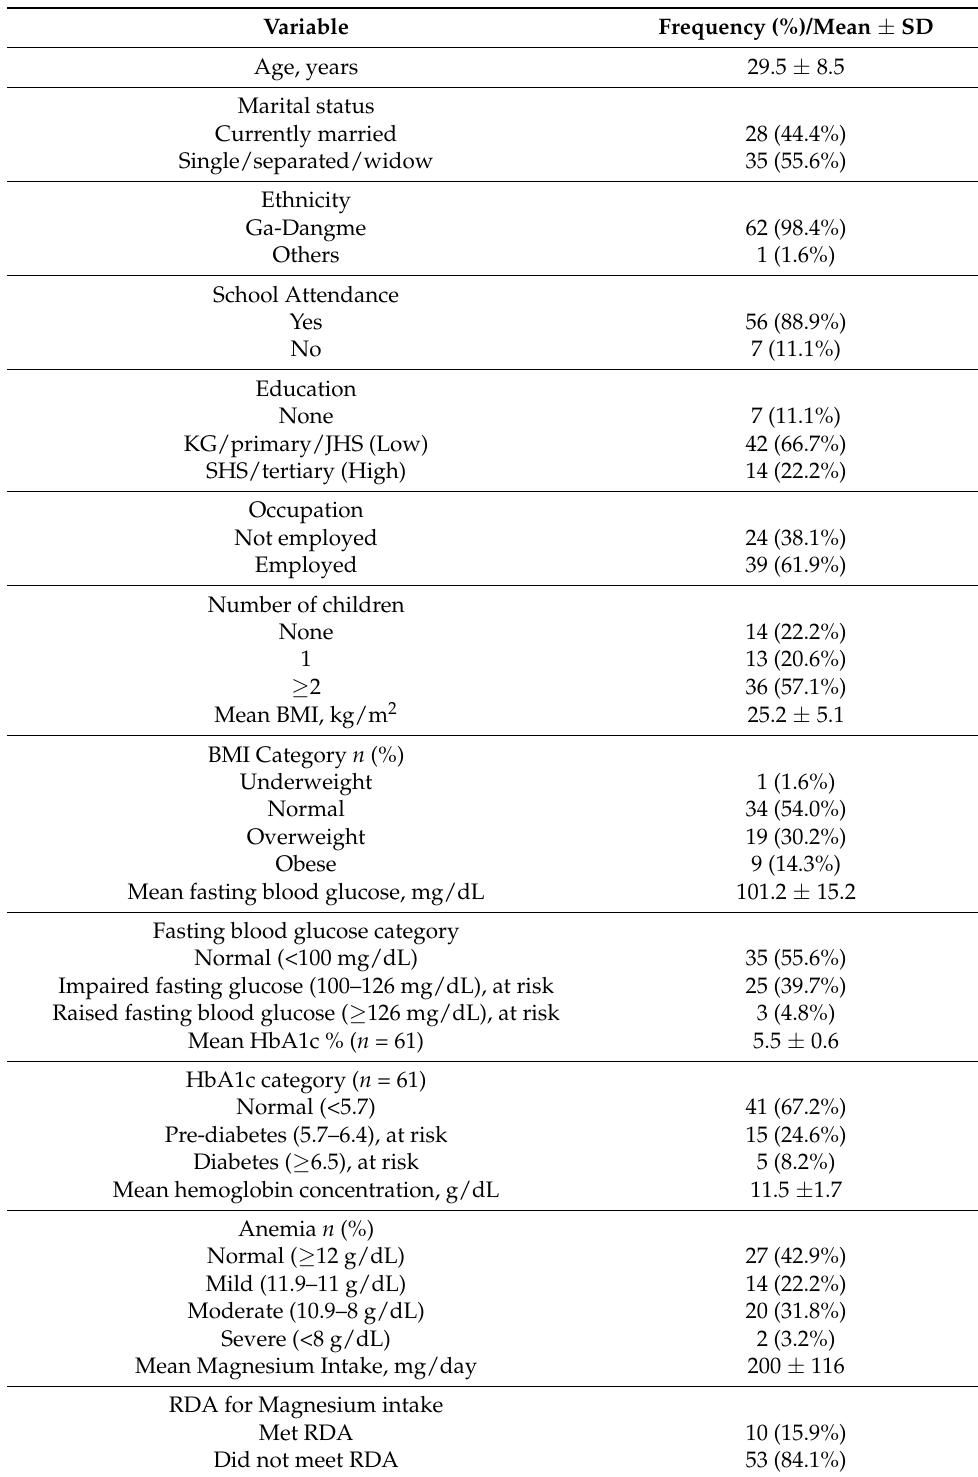
Table 1. Background characteristics of the study